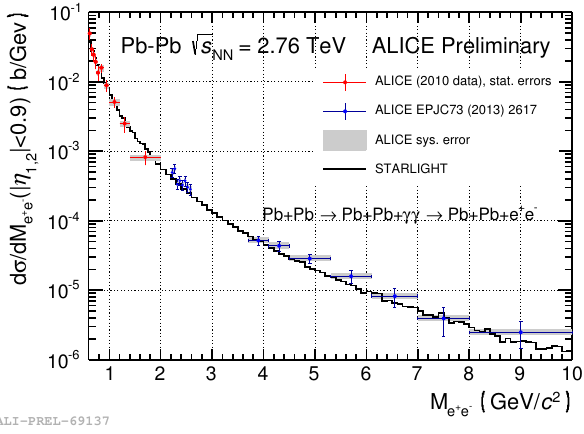
Figure 1. Continuum dielectron photoproduction cross section as function of dielectron invariant mass √ s NN = 2 . 76 TeV by the ALICE collaboration [5] in comparison with measured in Pb–Pb UPC at leading order QED predictions from STARLIGHT